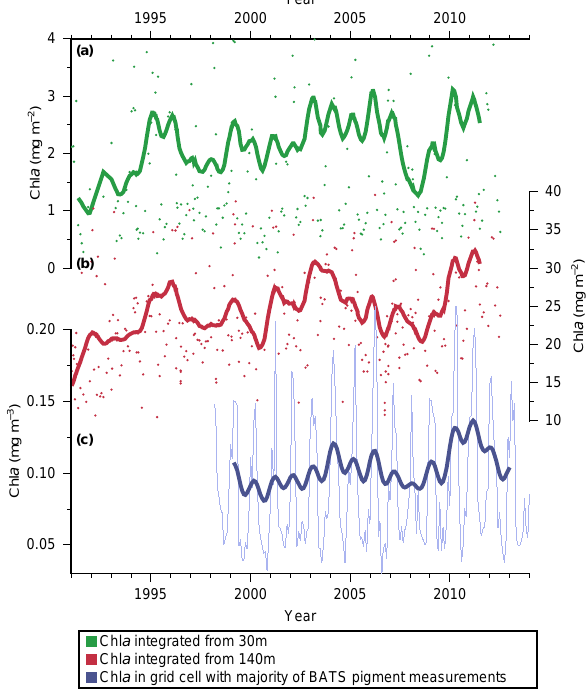
Figure 5. Chl a hapto measured at BATS and satellite-derived PIC. Chl a hapto integrated from 30m is shown in (a) , while Chl a hapto integrated from 140m depth is shown in (b) . PIC data shown in (c) were obtained from the 5min satellite grid cell with the most BATS measurements (see Fig. 1). Bolder lines represent a 2-year Gaussian filter on the data. We restricted the y axes in panels (a) and (b) to highlight the filtered data; see Fig. S3 to view all unfiltered data points.